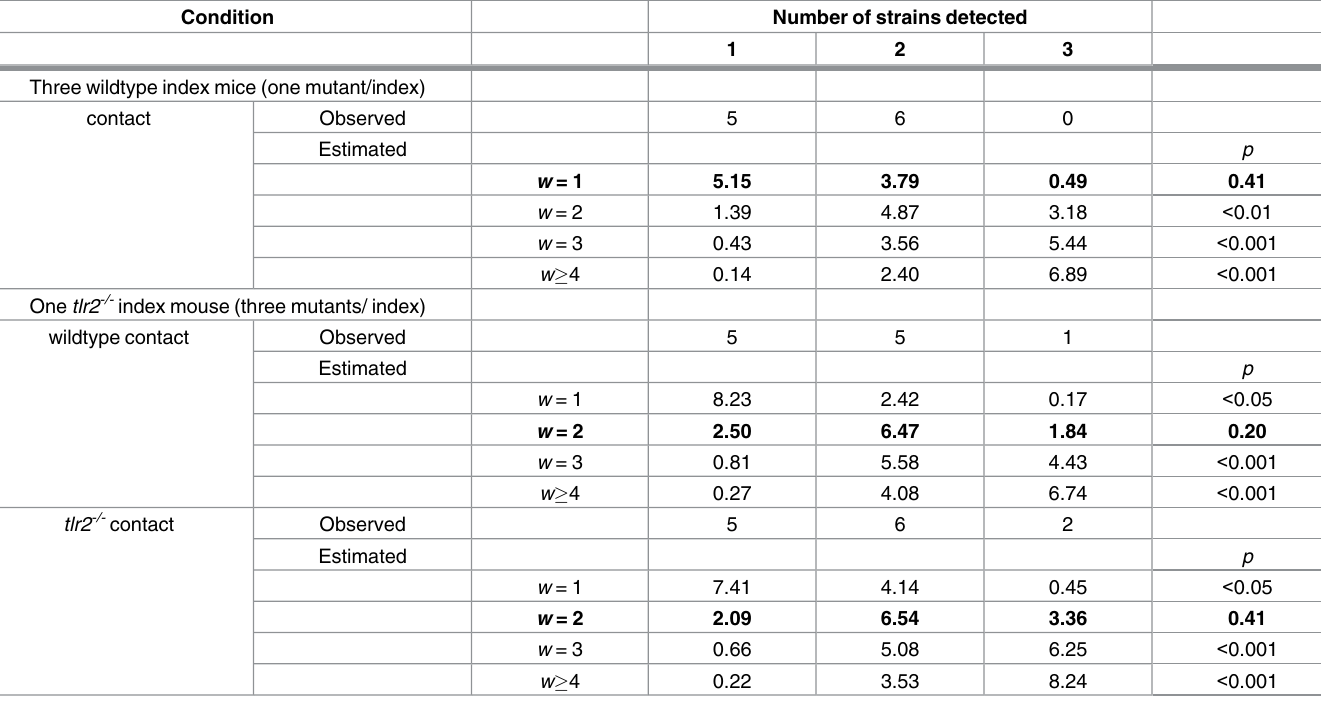
Table 3. Population bottleneck in transmission: Effects of the number and genotype of index